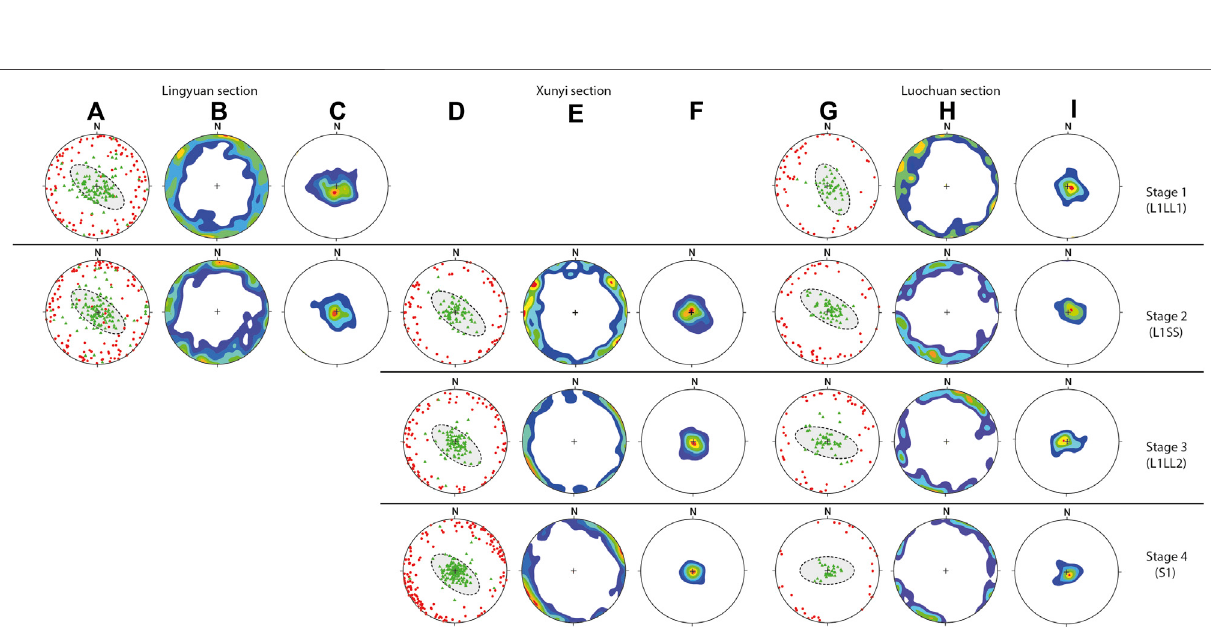
Frontiers in Earth Science |